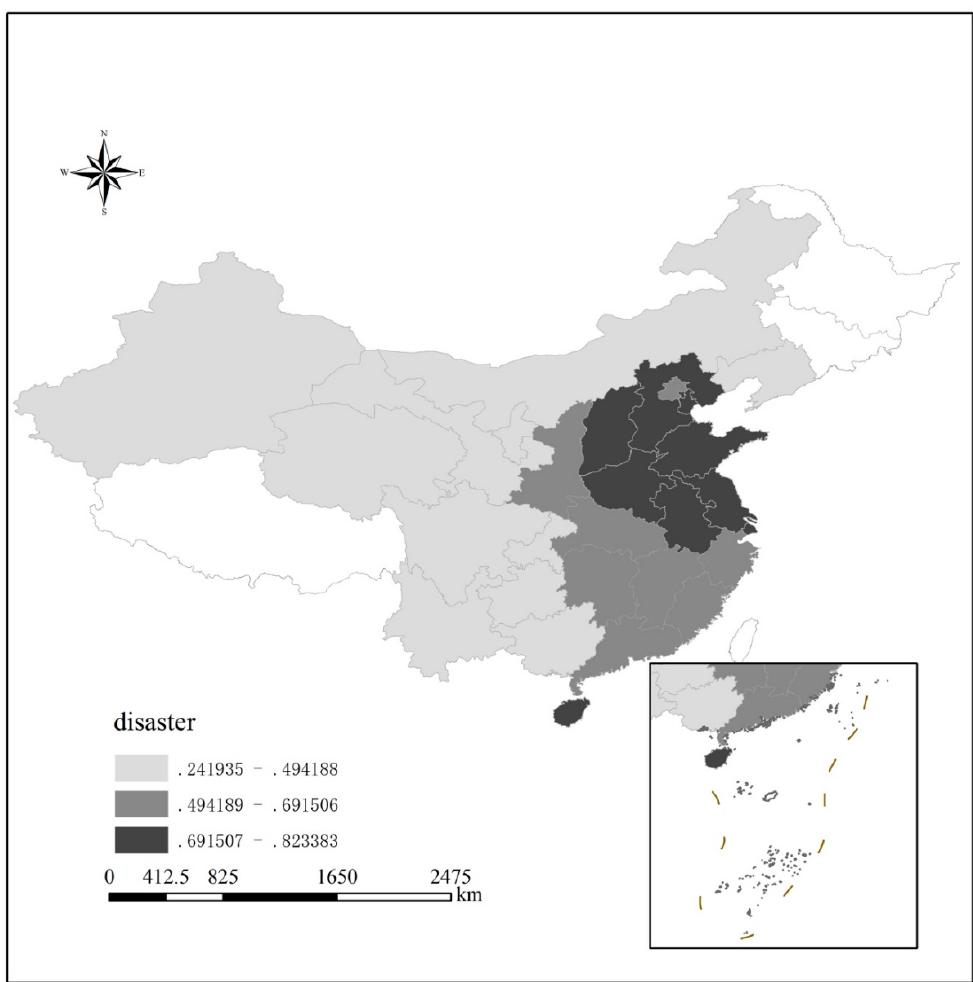
Figure 1. Regional differences in the frequency of flood and drought disasters in China during period of 1500–2000. Missing values shown as blanks in the figure.